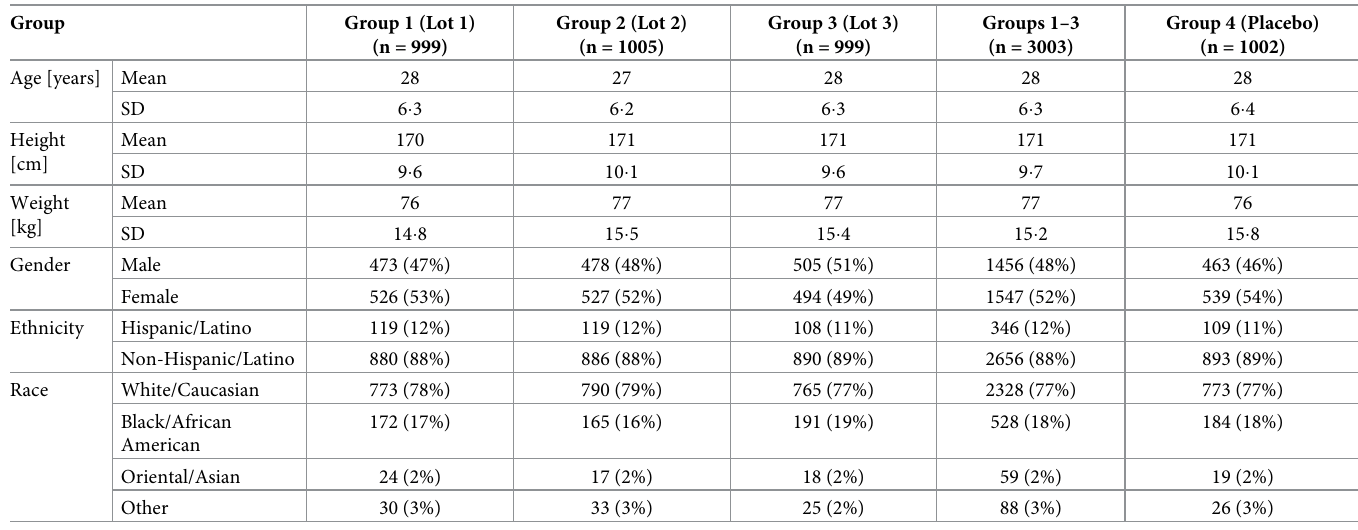
Table 1. Demographic data (FAS, n = 4005).